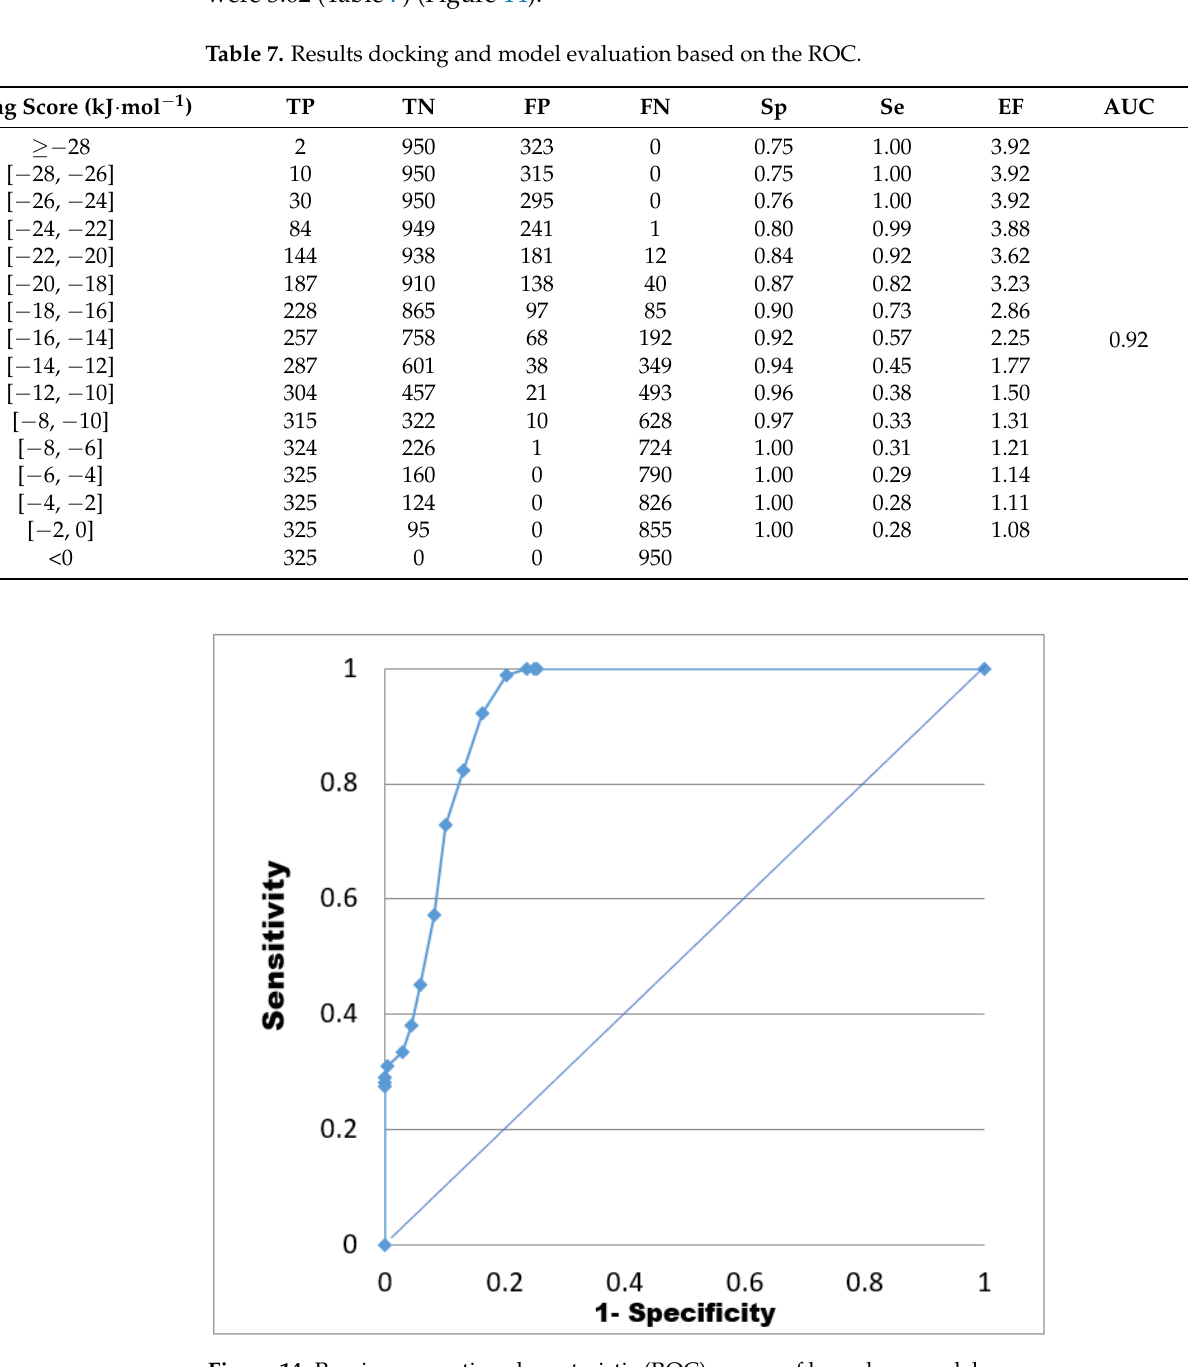
Figure 14. Receiver operating characteristic (ROC) curves of homology models .